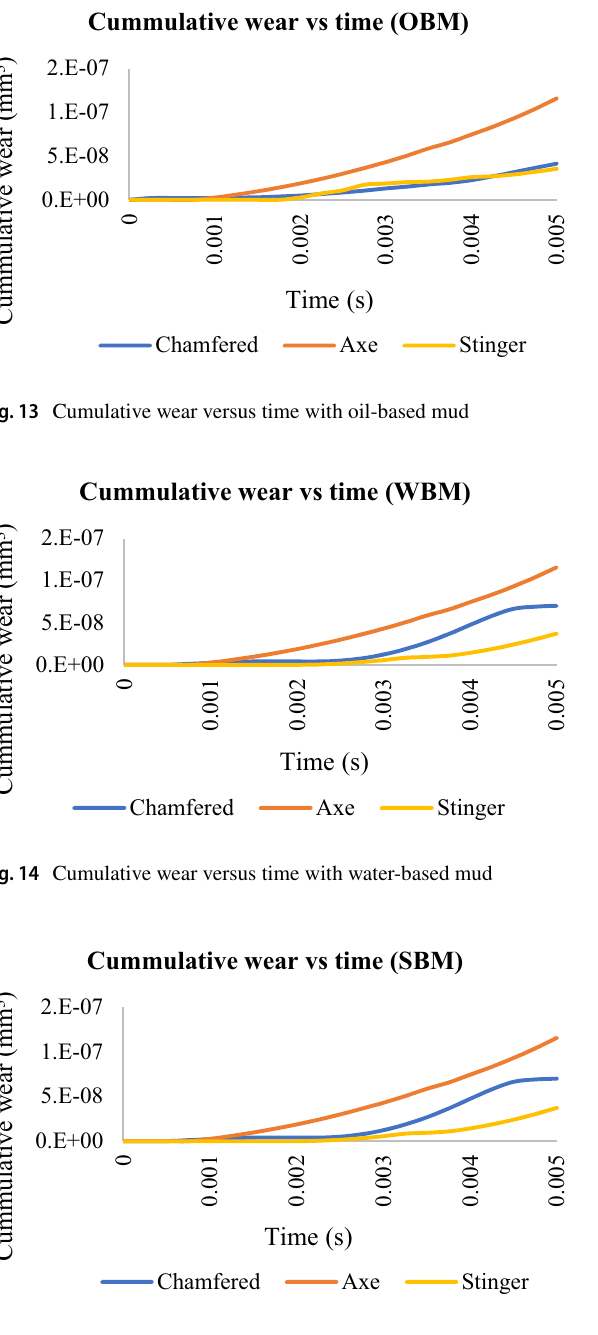
Fig. 15 Cumulative wear versus time with synthetic-based mud